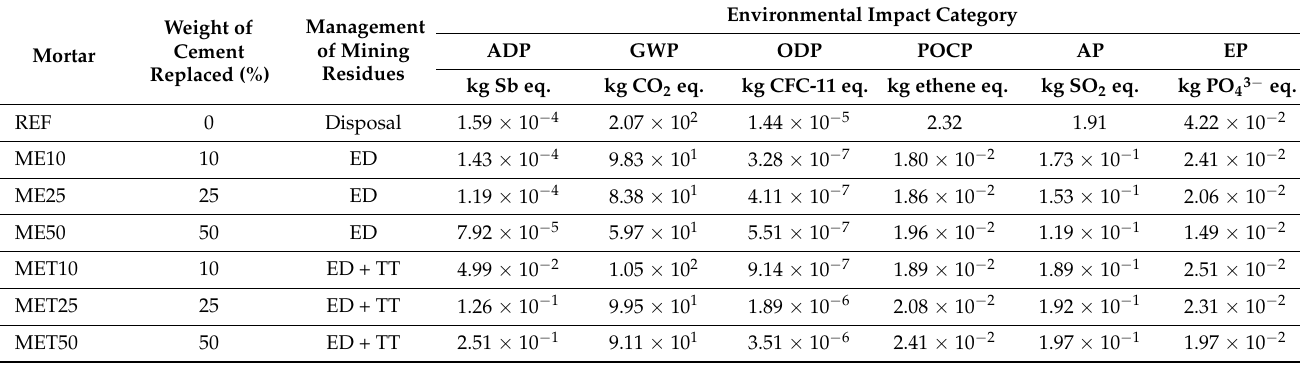
Table 5. Environmental impacts from the production of 1 t of mortars with cement and treated mining residues as binder